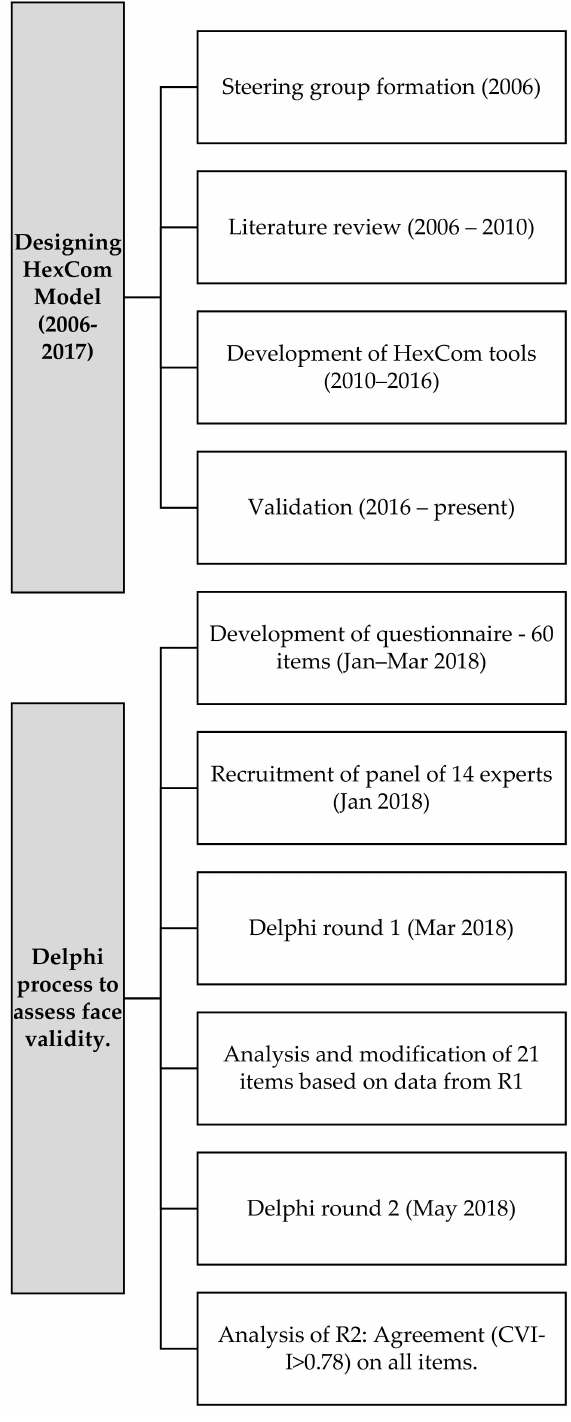
Figure 1. Process of development and validation of